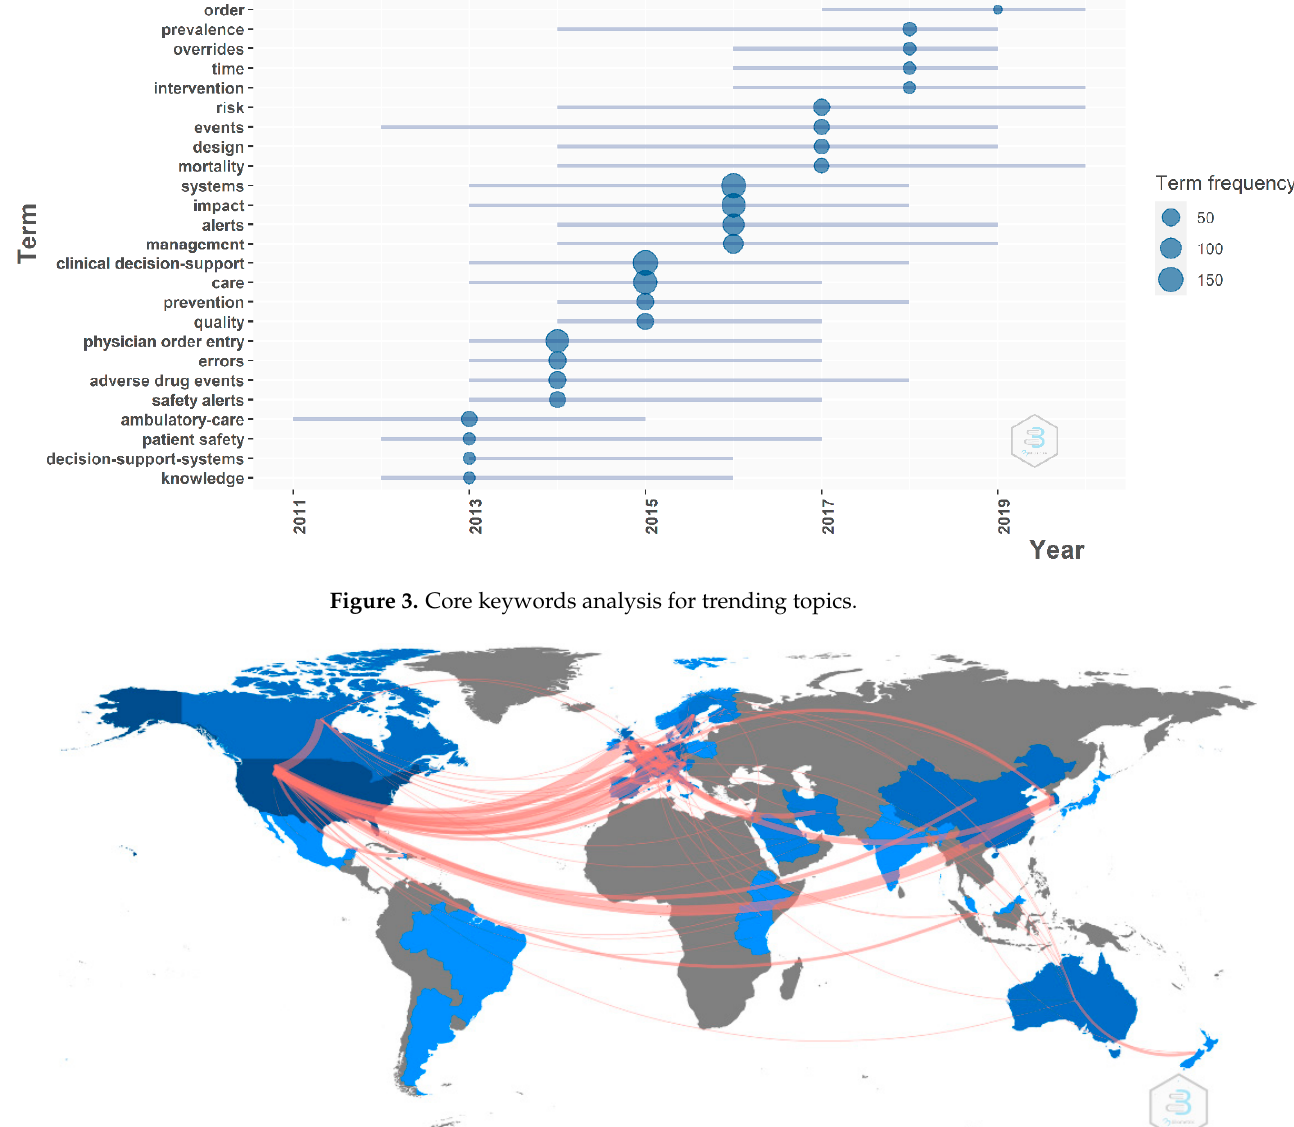
Figure 4. The country collaboration map for CDSS alert studies.